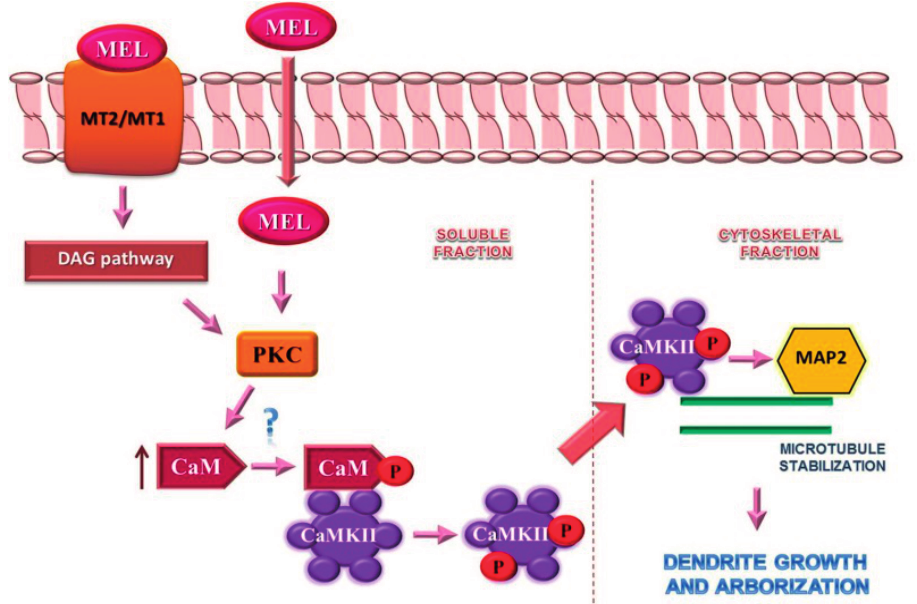
Figure 9. Schematic drawing of the signaling pathway by which Melatonin stimulates dendrite formation. Melatonin (MEL) binds to membrane receptors (MT2/MT1) to activate PKC through the diacylglycerol (DAG) pathway. Also, the indoleamine can diffuse through the plasmatic membrane to directly interact with protein kinase C (PKC). This enzyme may phosphorylate calmodulin (CaM), which can bind to Ca 2 + /CaM Kinase II (CaMKII) with higher affinity. CaM-activated CaMKII undergoes autophosphorylation which induces its targeting to the cytoskeletal compartment where it binds and phosphorylates MAP2 to constitute dendrites. Also, PKC may increase CaM levels in the soluble fraction by an enhanced biosynthesis or by targeting from the cytoskeletal to the soluble